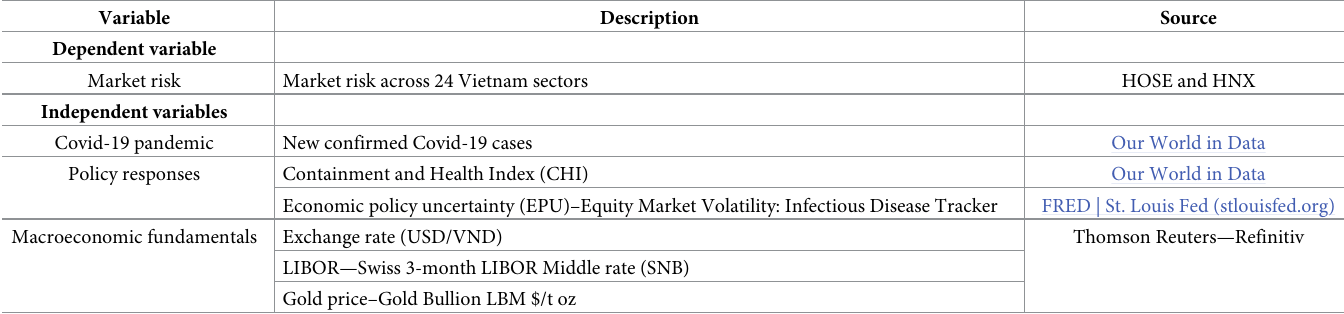
Table 1. Selected variables, descriptions, and